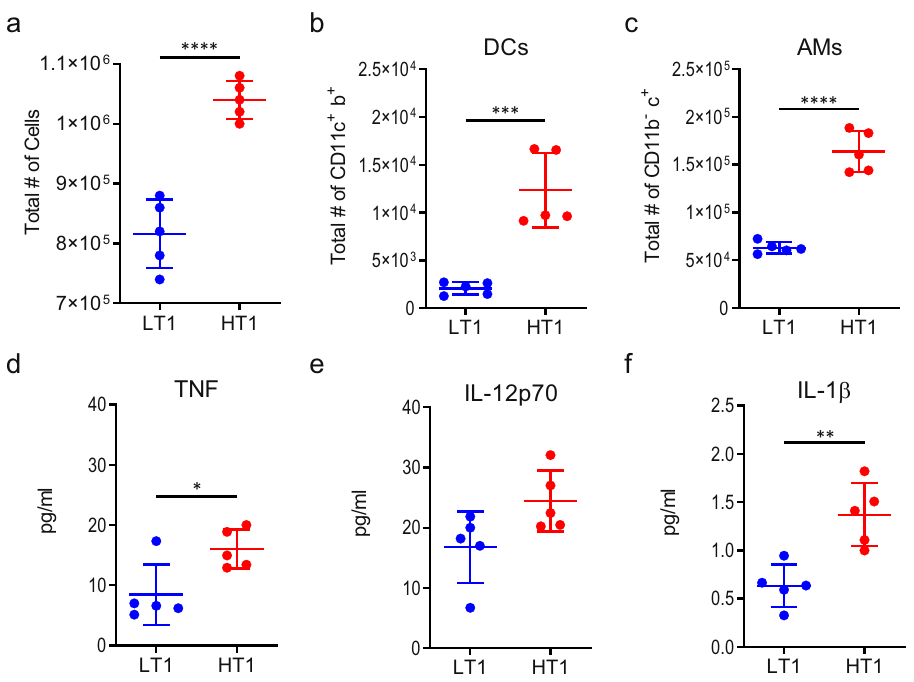
Fig. 3 Different microenvironments present in the lungs of Mtb-HT and Mtb-LT infected mice at week 2 post infection. a – f C3HeB/FeJ mice were infected with ~100 CFU of the indicated strain via Glas-Col aerosol exposure. At the indicated time post infection mice were sacri fi ced and single cell suspensions and total number of recruited cells ( a ) cDCs (CD3-CD19-CD11c + MHCII + ) ( b ) and AMs (CD3-CD19-CD11b-CD11c + SiglecF + ( c ) were calculated following acquisition on LSRFortessa X-20 and FlowJo analysis. MSD ELISA of lung lysates was used to determine TNF α ( d ), IL-12 ( e ), and IL-1 β ( f ) protein levels. Data are presented as mean values + / − SD. Source data are provided as a Source Data fi le. Sample size of n = 5 mice was included in each group. Signi fi cance was determined using unpaired t test. * P = 0.0217, ** P = 0.0031, *** P < 0.001, **** P < 0.0001. The experiment was repeated with Mtb-HT2 and